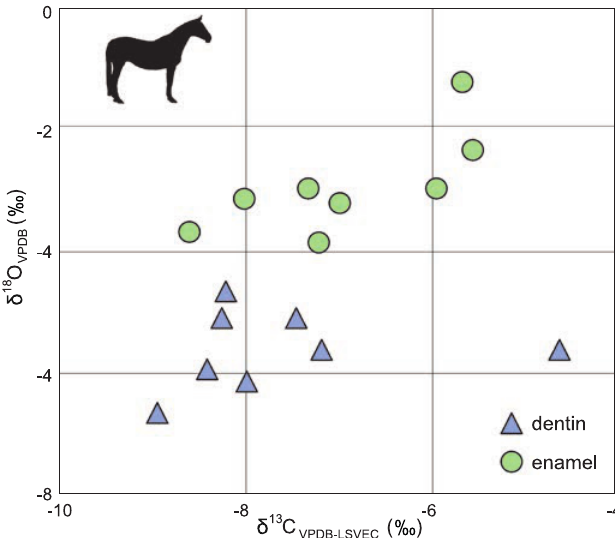
Fig. 4. Comparison of dental tissues (dentin versus enamel) and their d 13 C and d 18 O isotopes in unidentified horse teeth from the Optima Local Fauna (Miocene, late Hemphillian, Oklahoma, USA). R 2 = 0.0002 for dentin, 0.5054 for